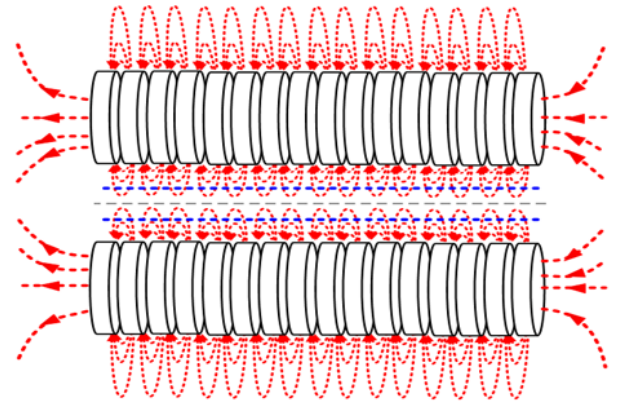
Figure 5. The magnetic field line of a parallel pole combination bar magnet.